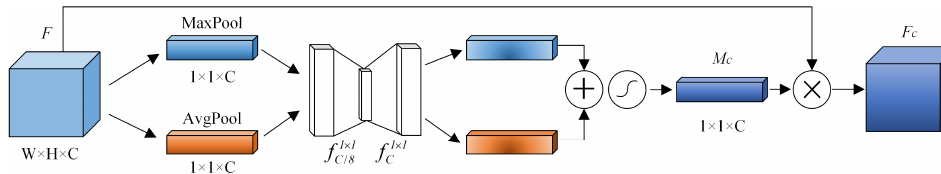
Figure 6. Channel a tt ention mechanism. Figure 6. Channel attention mechanism.